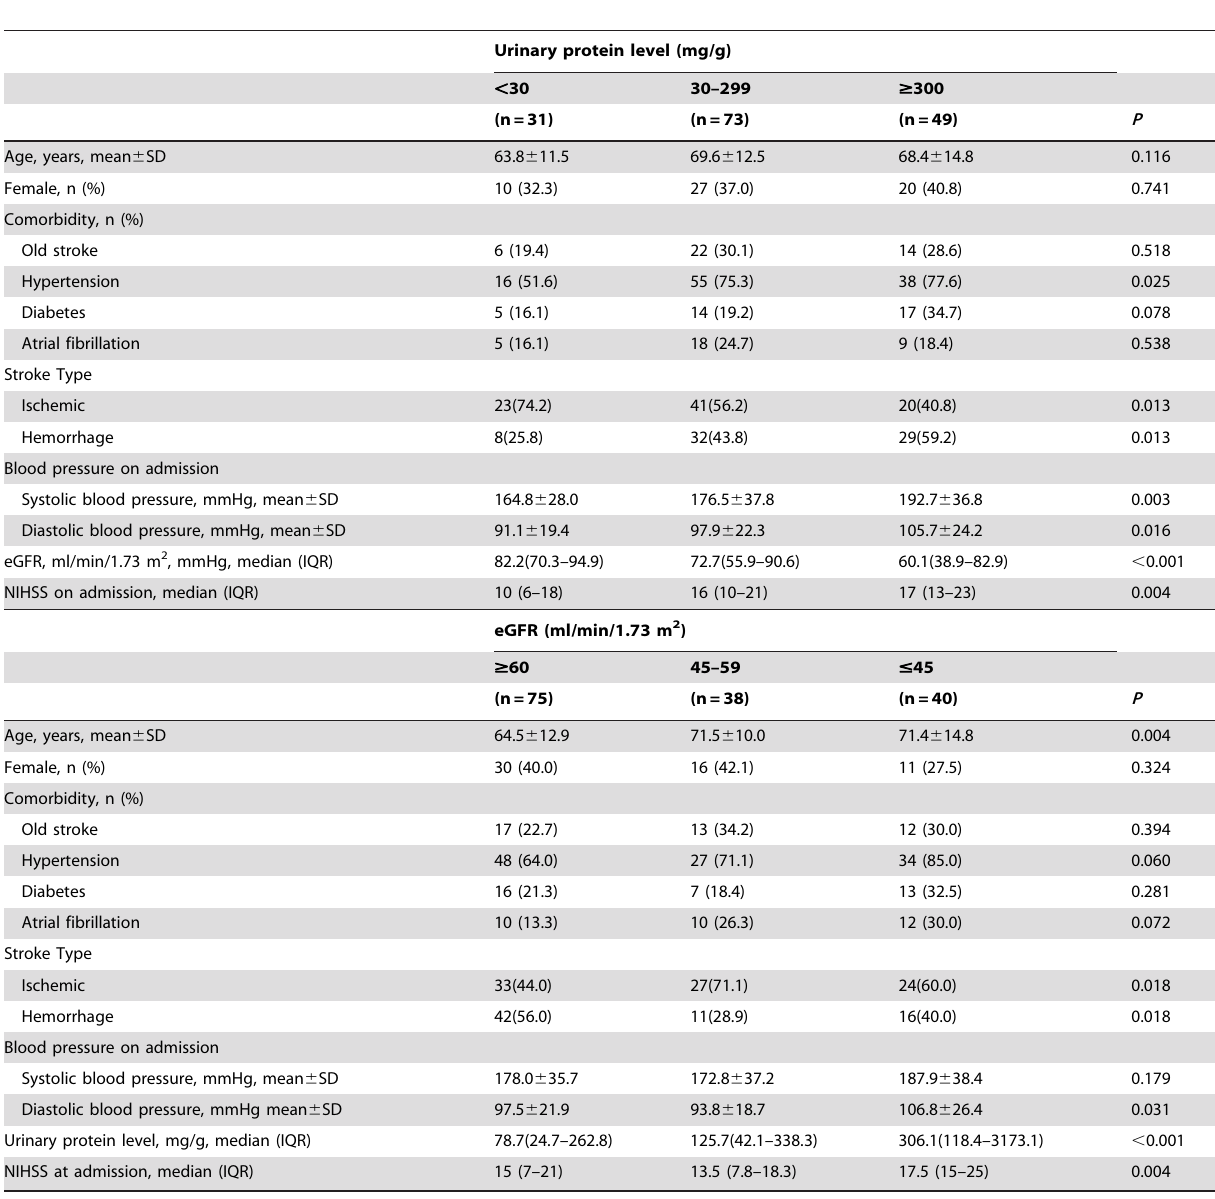
Table 2. The clinical characteristics of the patients according to the urinary protein level and eGFR